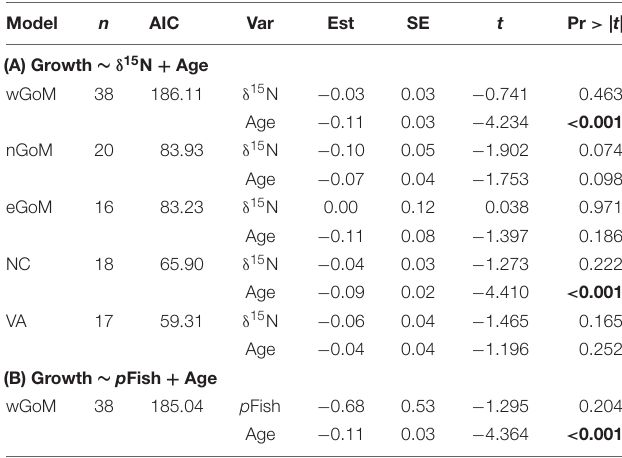
(A) Comparison of δ 15 N values and growth rates across all regions. (B) Comparison of median percent of fish in diet (pFish) on growth rates for western GoM turtles only. Bold signifies statistically significant